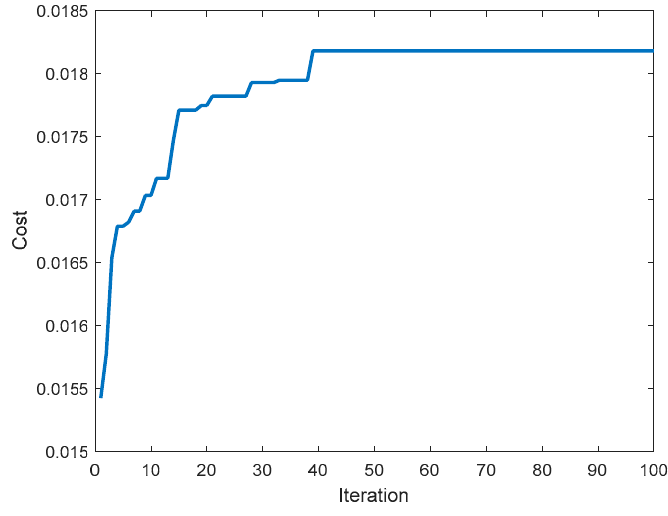
Figure 5. The process of searching for 20 optimal poses.